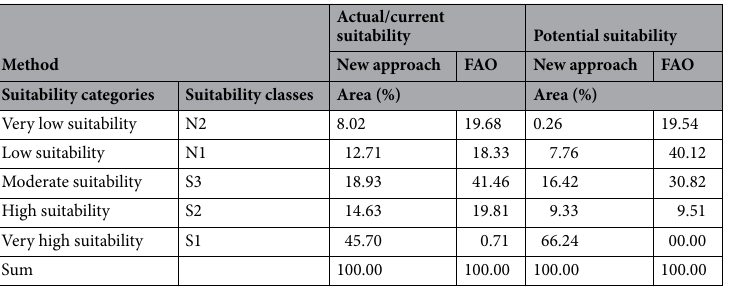
Table 14. Total area of suitability classes using the FAO and the new approach for land suitability